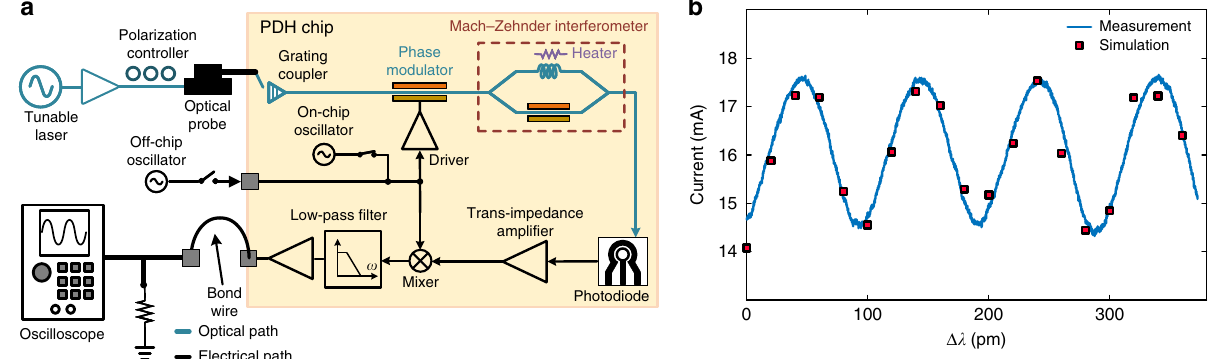
Fig. 4 Open-loop measurement. a The block diagram of the Pound − Drever − Hall (PDH) open-loop measurement setup. An optical probe is used to couple the ampli fi ed output of an Agilent 81642A laser into the PDH chip. The output current of the voltage-to-current converter is used to drive a load emulating the impedance of the laser gain section and is monitored using an oscilloscope. b The simulated open-loop PDH read-out current (at A i = 82 dB) is shown which follows a sinusoidal form as predicted by eq. (1). The measured PDH open-loop read-out signal is also shown which is in close agreement with